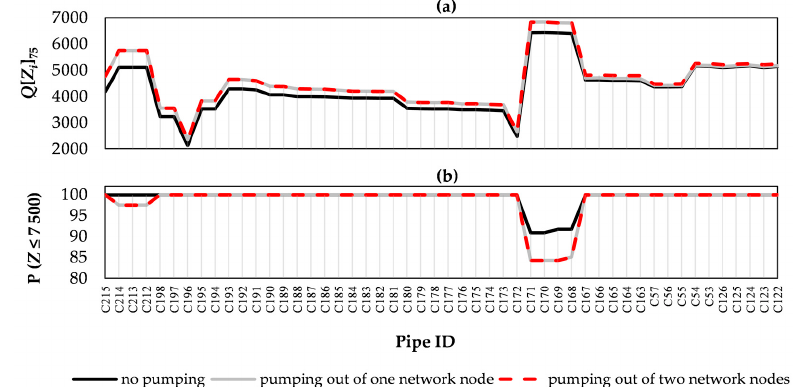
Figure 11. Hydrogen sulfide production across the optimal pipe path of area ID 3 in cases of different pumping approaches. ( a ) The first panel shows Q [ Z i ] 75 values in all pipes of the path; ( b ) The second panel depicts the non-exceedance probability of the Z ≤ 7500 threshold with respect to the path’s pipes. Both panels concern steady-rate pumping for a twenty-four-hour period.